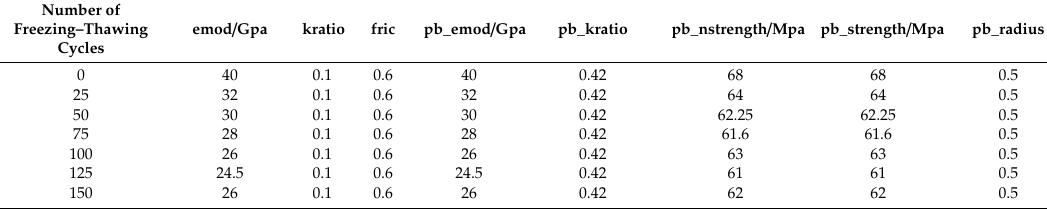
Table 3. Meso-parameters of cement mortar bonding of the damaged layer.